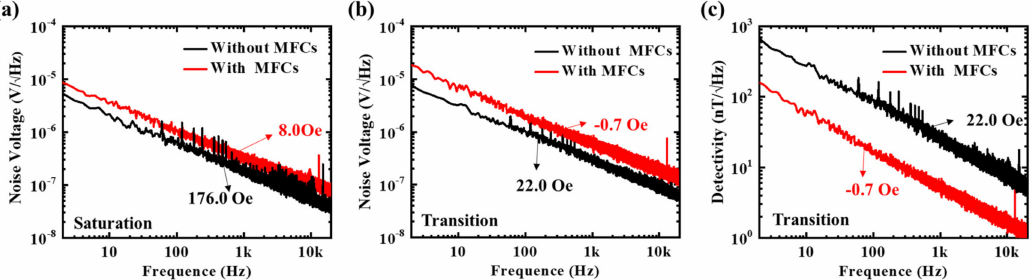
Figure 7. Noise spectra of the MTJ sensor with and without the double-gap MFC at ( a ) saturation state and ( b ) transition, ( c ) the detectivity of the MTJ sensor with the double-gap MFC at a DC magnetic bias field, which results in highest sensitivity, the magnetic field marked in the figure indicates the external magnet for noise